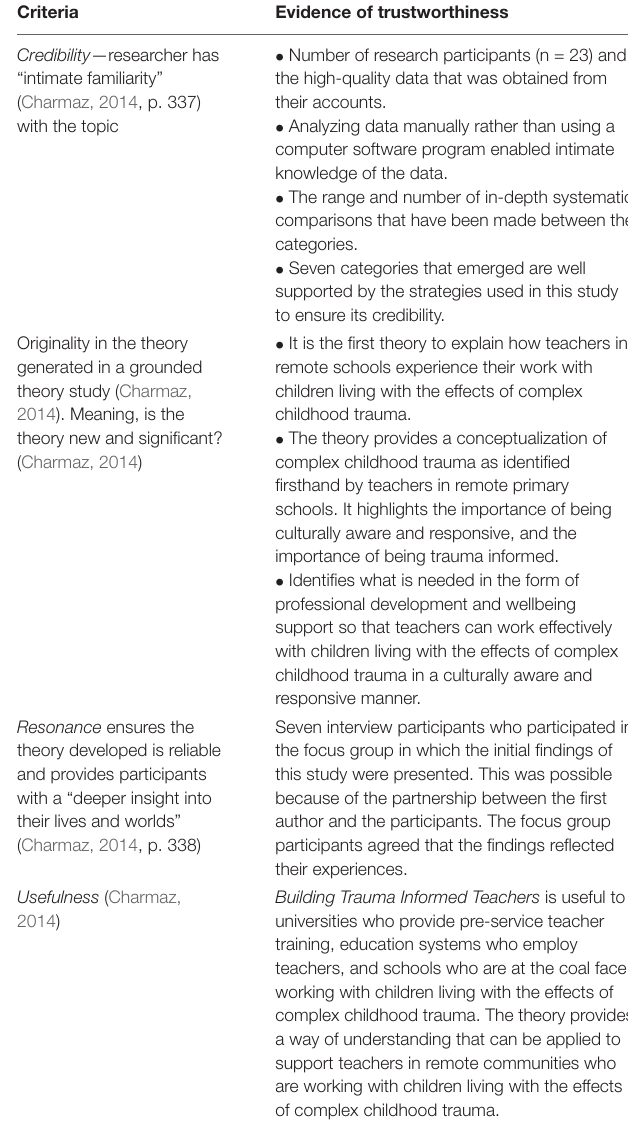
TABLE 1 | Evaluation criteria for this grounded theory